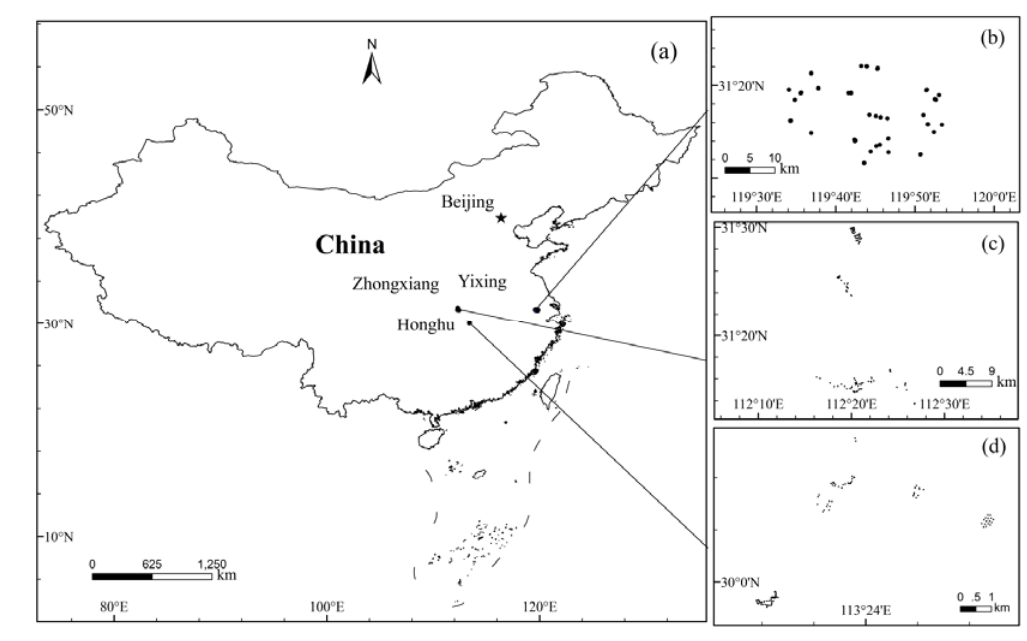
Figure 1. ( a ) Study areas and the spatial distributions of soil samples in ( b ) Yixing, ( c ) Zhongxiang and ( d )